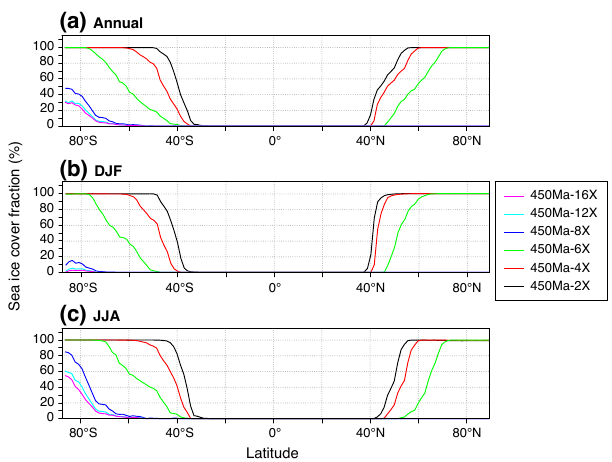
Figure 5. Zonally averaged sea ice cover fraction (expressed in percents) simulated for each p CO 2 at 450Ma with the fully cou- pled version of FOAM. DJF: December, January and February. JJA: June, July and